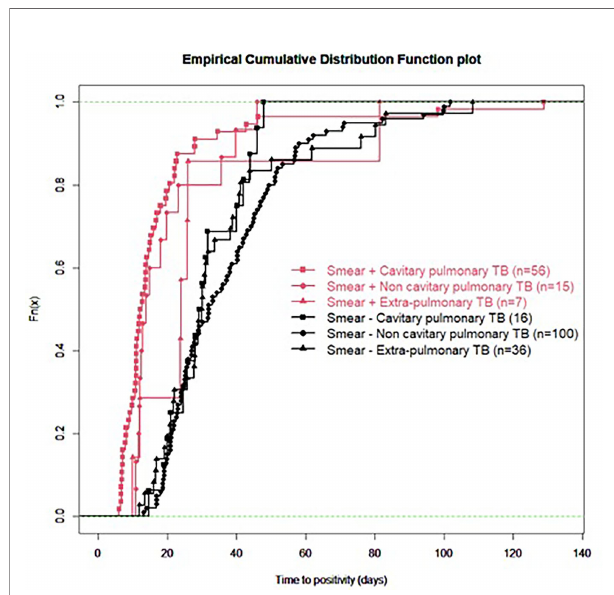
FIGURE 3 | Empirical cumulative distribution function plot of time to detection of growth in samples according to microscopy (positive i.e. presence of acid-fast bacilli (AFB), vs negative: absence of AFB) and clinical presentation (cavitary vs. non-cavitary pulmonary tuberculosis vs. extra- pulmonary tuberculosis). All samples are PCR